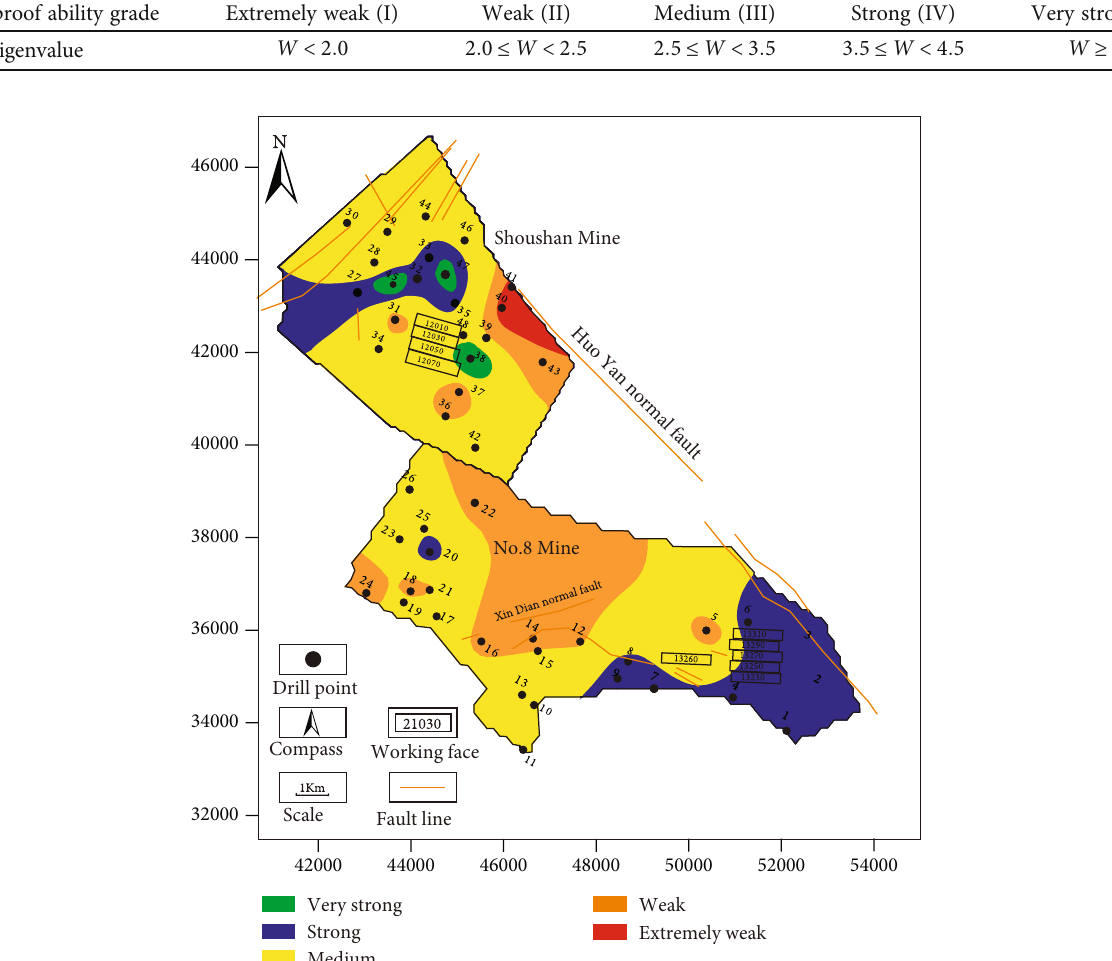
Figure 6: Zoning map of the water insulation capability for the J